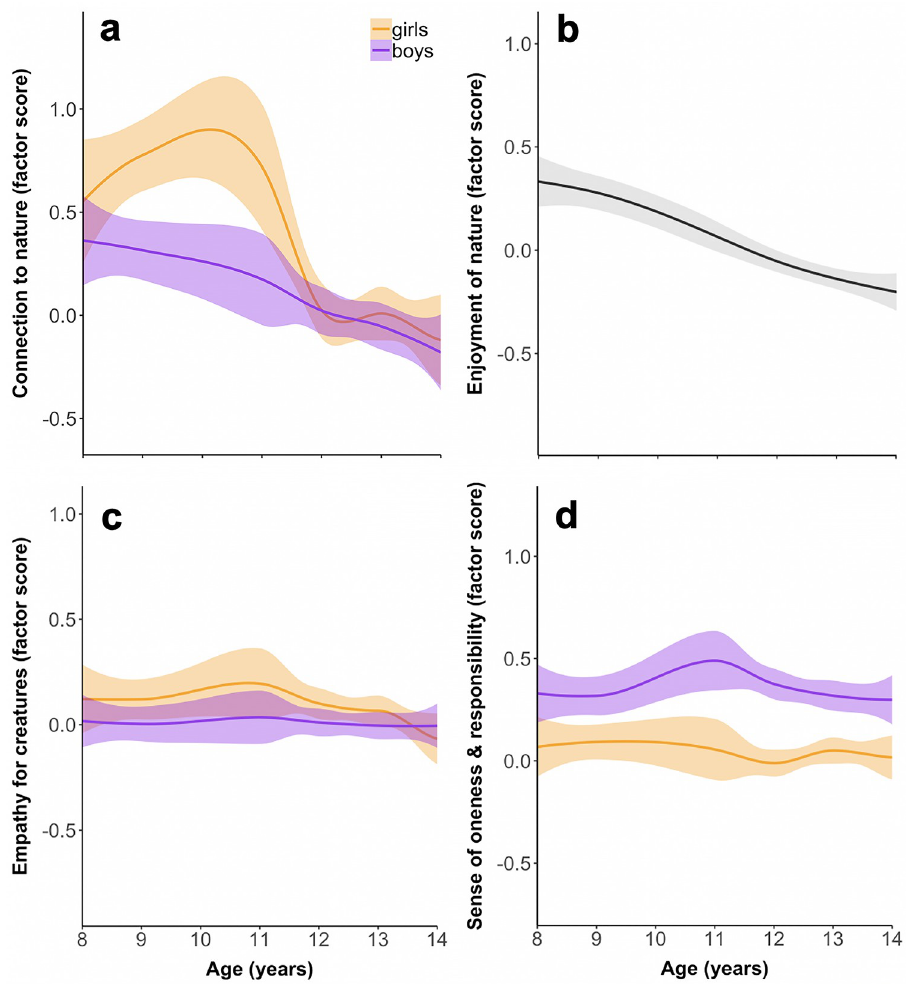
Fig 2. Factor scores for (a) connection to nature and (b–d) its component measures, across middle childhood and adolescent years. Boys and girls were pooled for visualization in panel b because gender did not significantly impact enjoyment of nature. Trend lines are smoothed Loess curves showing conditional means with 95% CI shaded. N = 1,037 (569 girls and 468 boys); see S1 Table for a breakdown by